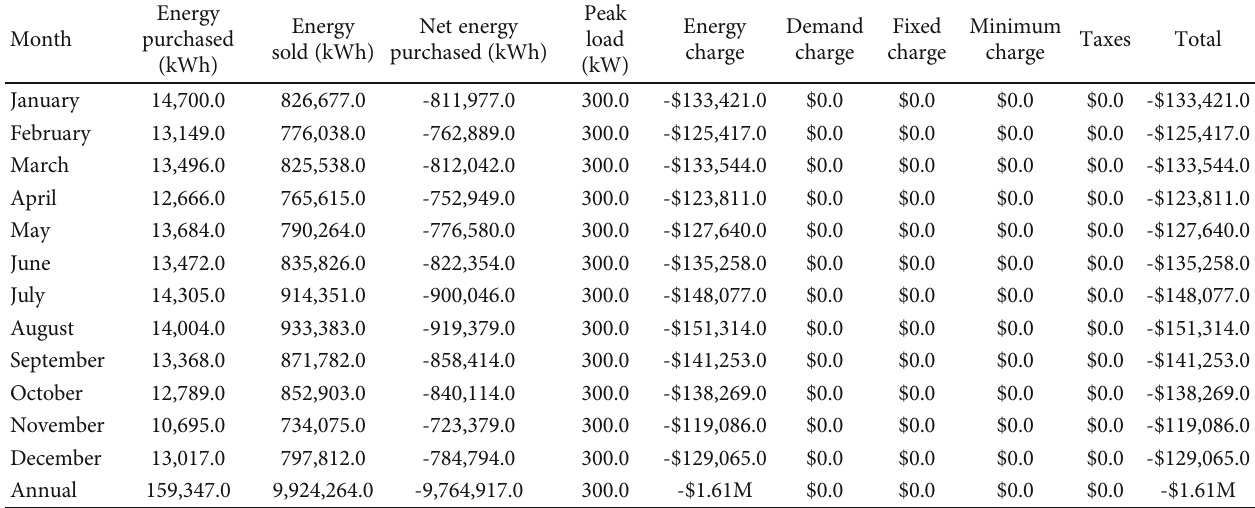
Table 9: Utility monthly summary for the proposed